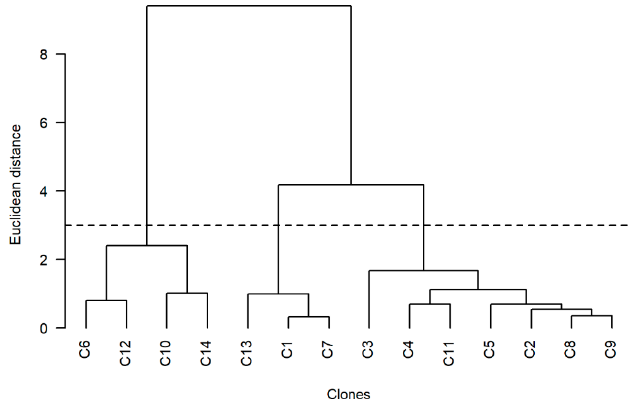
Figure 4. Dendrogram of the cluster analysis using Ward’s method and the Euclidean distance with interception of the branches by the horizontal dashed line for the formation of clusters with Eucalyptus clones: group A: C3, C4, C11, C5, C2, C8, and C9; group B: C13, C1, and C7; and group C: C6, C12, C10, and C14.